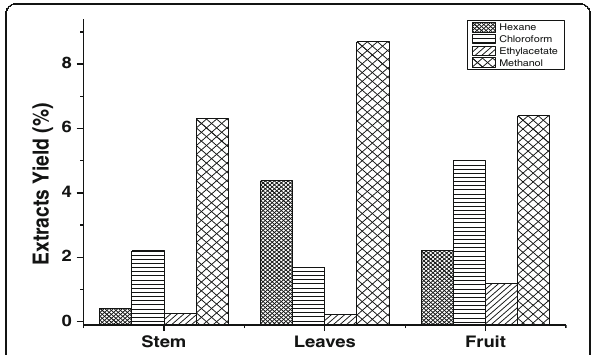
Fig. 1 Extract yields of R. stricta using different solvents of varying